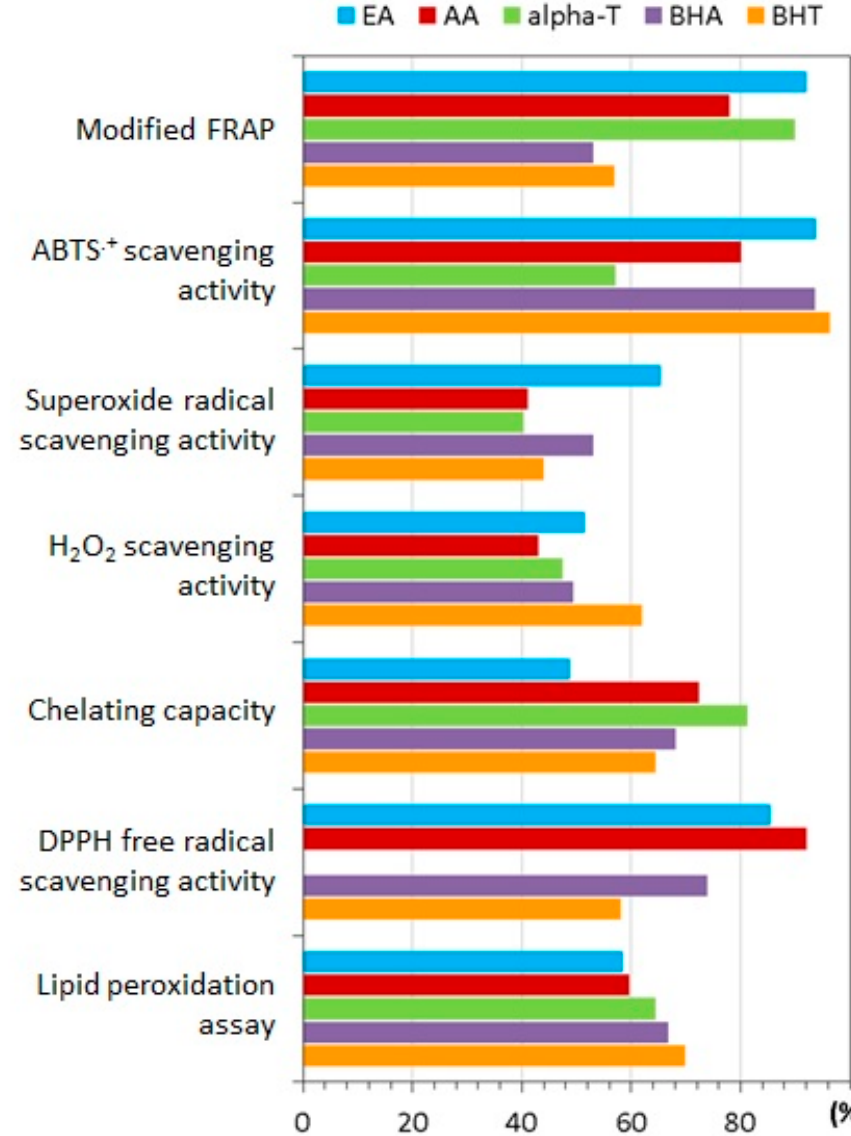
Figure 4. In vitro radical scavenging and antioxidant capacity studies of ellagic acid (EA) vs. butylated hydroxyanisole (BHA), butylated hydroxytoluene (BHT), alfa-tocopherol (alpha-T) and ascorbic acid (AA). The values are presented in percentages at the same concentrations, except for the modified FRAP test, which indicates the absorbance of the reaction mixture (adapted from [120]).